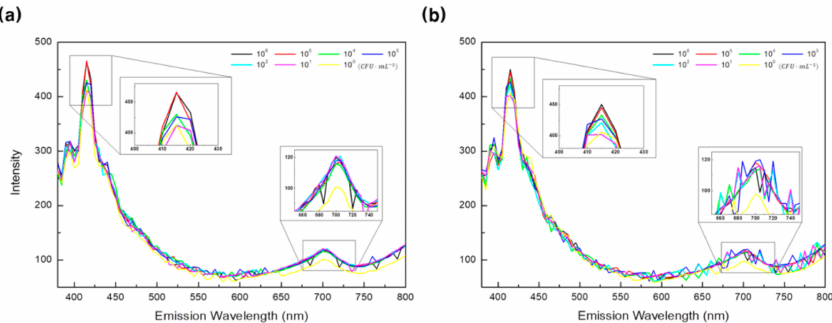
Figure 5. Fluorescence emission spectra for six concentrations (10 5 , 10 4 , 10 3 , 10 2 , 10 1 , and 10 0 CFU · mL − 1 ) of food poisoning bacteria for 365 nm excitation light: ( a ) E. coli and ( b ) S. typhimurium